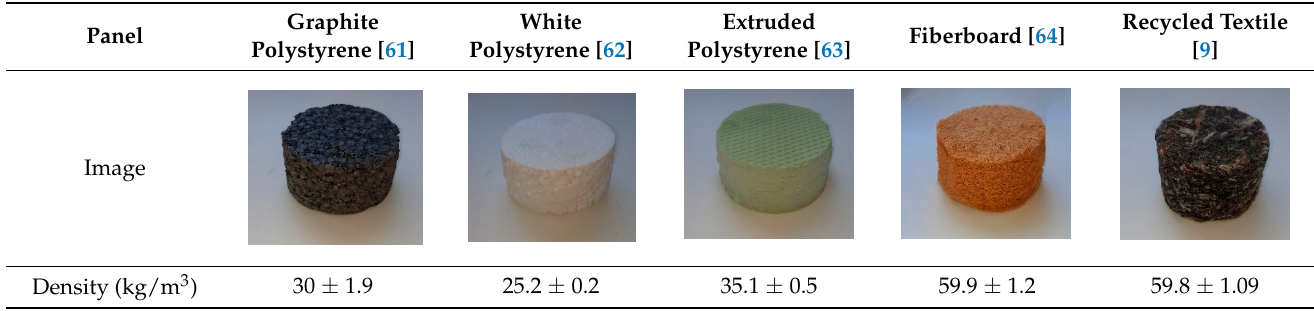
Table 4. Overview of parameters of tested commercially available insulating materials. Panel Mineral Wool [65]